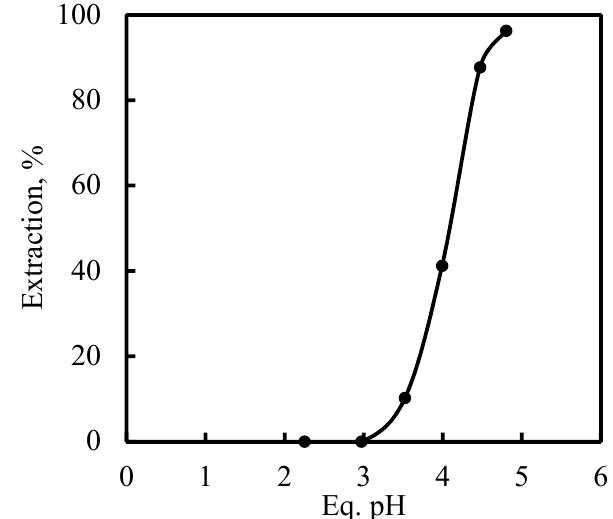
Figure 9. E ff ect of equilibrium pH on the extraction of nickel with mixture of HDEHP and Figure 9. Effect of equilibrium pH on the extraction of nickel with mixture of HDEHP and TEHA.